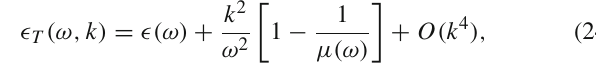
Fig. 2 The condensate and grand potential as a function of the chem- ical potential with the fixed coefficient ξ = 0 . 2 (top) and ξ = 0 . 5 (bottom) for different values of the coupling parameter η in the case of the graviton mass m = 1 . 0. For the left two panels, the four lines in each panel from top to bottom correspond to increasing coupling parameter,